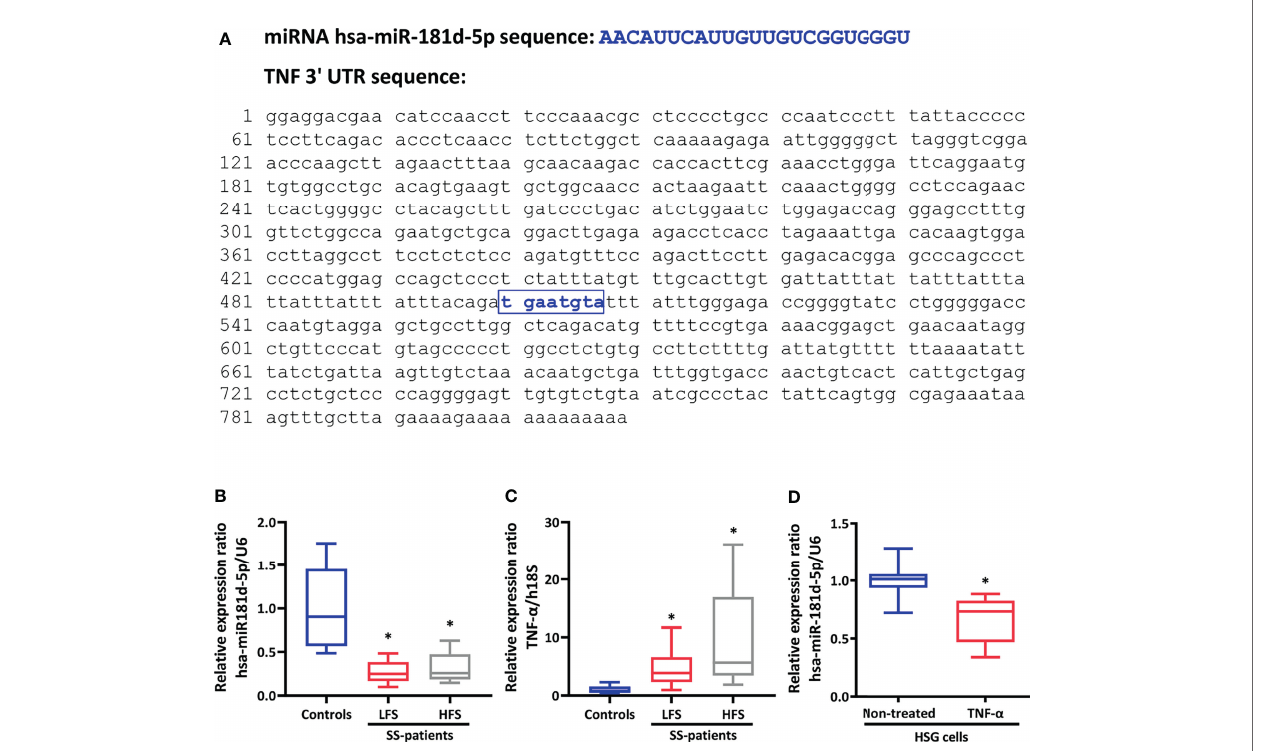
FIGURE 3 | hsa-miR-181d-5p is downregulated and TNF- a is overexpressed in LSG from SS-patients. (A) The hsa-miR-181d-5p and TNF- a 3 ’ -UTR sequences are shown. The box highlights the seed sequence. (B) Levels of hsa-miR-181d-5p in sicca controls (n=6) and SS-patients with low (n=10) and high focus score (n=5). U6 snRNA was used as a housekeeping. (C) TNF- a transcript levels in sicca controls (n=6) and SS-patients with low (n=10) and high focus score (n=5). h18S was used as a housekeeping gene. (D) Levels of hsa-miR-181d-5p in HSG cells stimulated with or without 1 ng/mL TNF- a . Data are representative of at least three independent measurements. (*) p-value ≤ 0.05 was considered signi fi